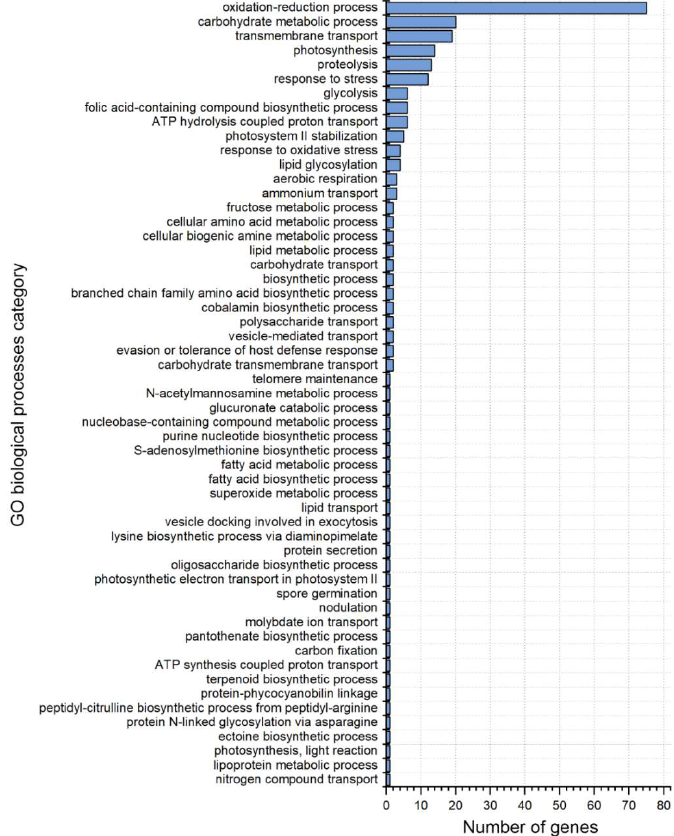
Figure 5. Bar graph of co-expressed Symbiodiniaceae sequences based on GO biological processes categories. The vertical axis represents the GO terms, and the horizontal axis represents the number of transcripts annotated to the terms (including sub-terms of the terms). Table 5. Presence of key circadian clock gene homologues in representative